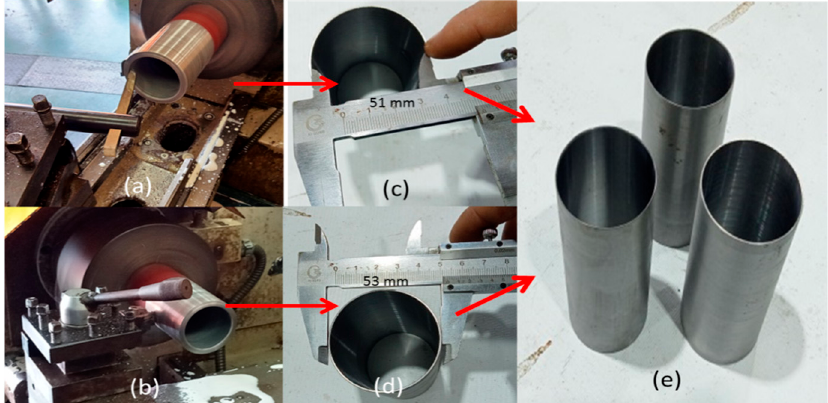
Figure 3. Machining process on MS pipe to make metal tube confinement on TSPC specimen. ( a ) Internal surface lathe (turning). ( b ) External surface lathe (turning). ( c ) Internal diameter increased from 49 mm to 51 mm. ( d ) Outside diameter decreased from 61 mm to 53 mm. ( e ) The finished and metal tube confinement (1 mm thickness).